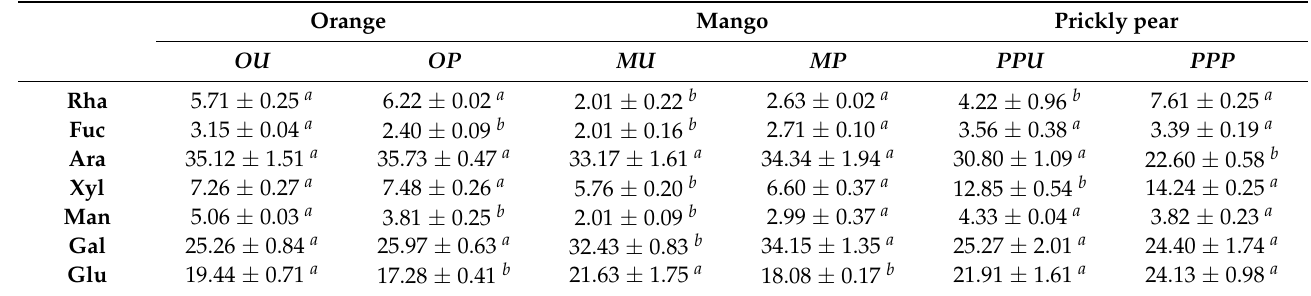
Table 1. Neutral sugars profile of orange, mango and prickly pear untreated and processed peels (% of total